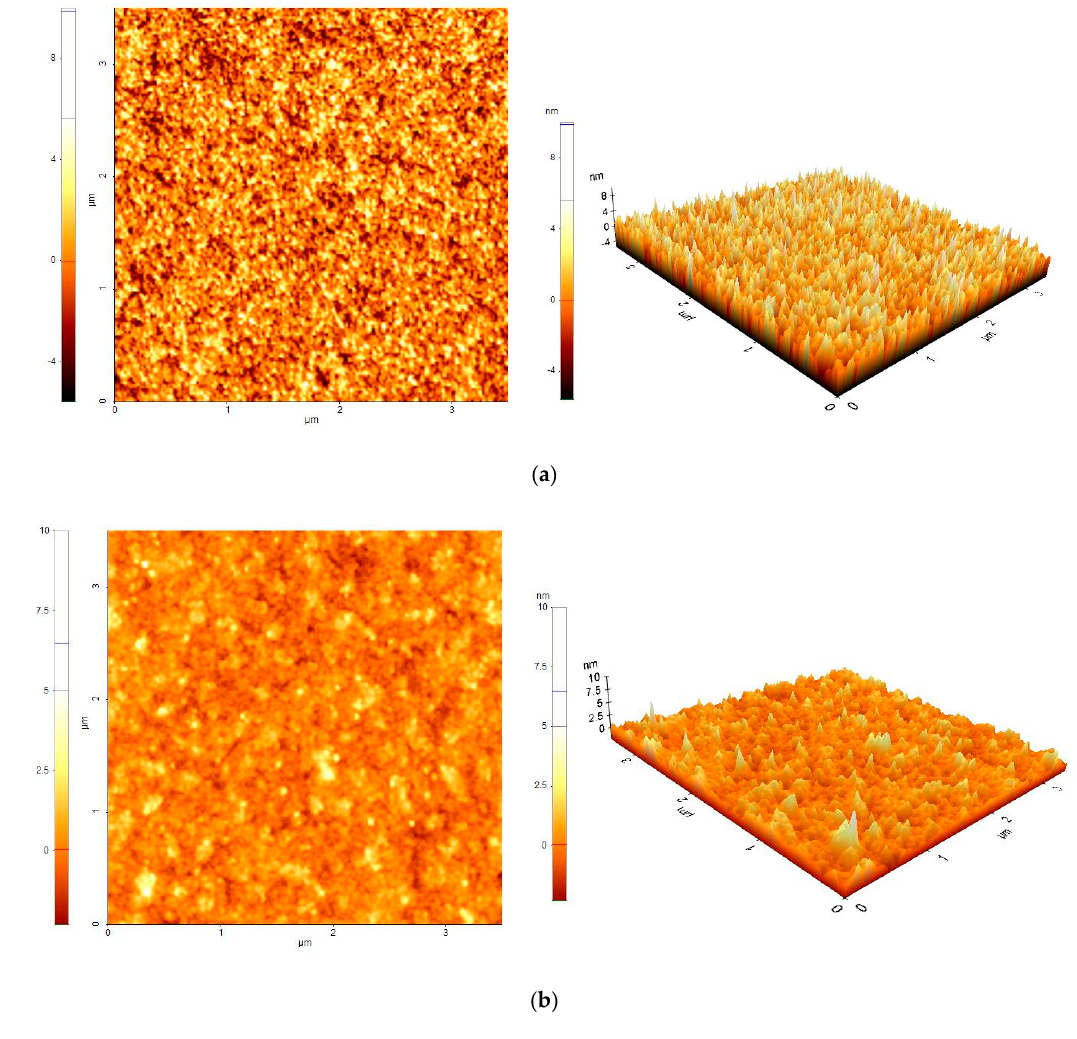
Figure 5. Atomic force microscopy (AFM) images of mixed EMLs on the ZnO / ITO glass: ( a ) without Figure 5. A tomic force microscopy (AFM) images of mixed EMLs on the ZnO/ITO glass: ( a ) without PS (R q = 1.627 nm) and ( b ) with PS (R q = 0.733 PS (R q = 1.627 nm) and ( b ) with PS (R q = 0.733 nm).